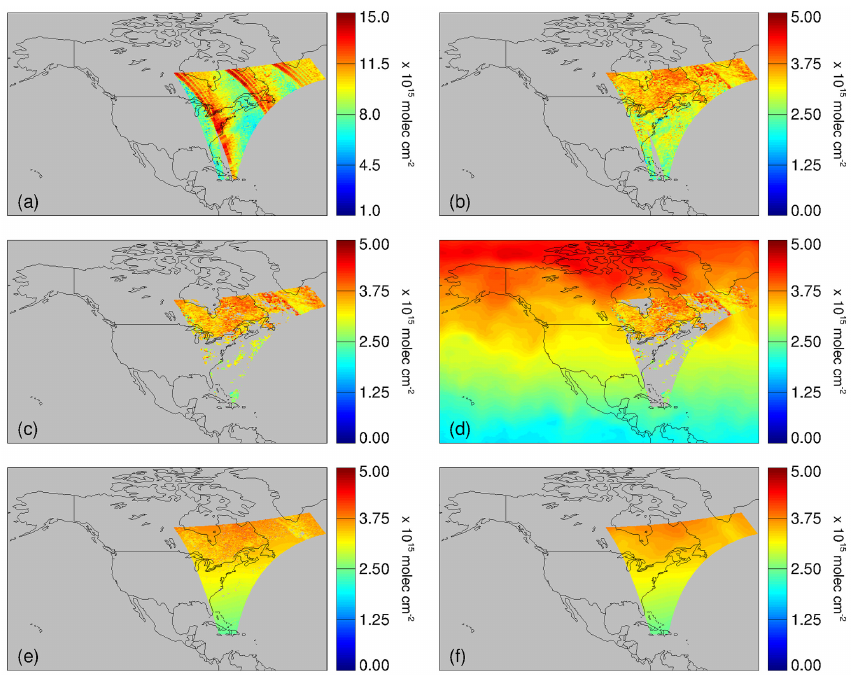
Figure 3. Calculation of the stratospheric NO 2 estimate on 15 July 2007, using OMI observations from within the anticipated TEMPO field of regard at 11:30UTC (06:30 Eastern Standard Time): (a) slant columns on a 0 . 1 ◦ × 0 . 1 ◦ grid. (b) Initial stratospheric estimate ( V init ) resulting from Eqs. (1) and (2). (c) Masked V init using a threshold of S trop /A strat < 0 . 3 × 10 15 moleculescm − 2 to remove large tropospheric influence. (d) Adding context outside of the TEMPO field of regard by using independent low-Earth-orbit observations from GOME-2 that have been corrected for time of day. (e) Stratospheric NO 2 estimate with masked areas interpolated and smoothed. (f) Stratospheric NO 2 estimate after final hot spot removal